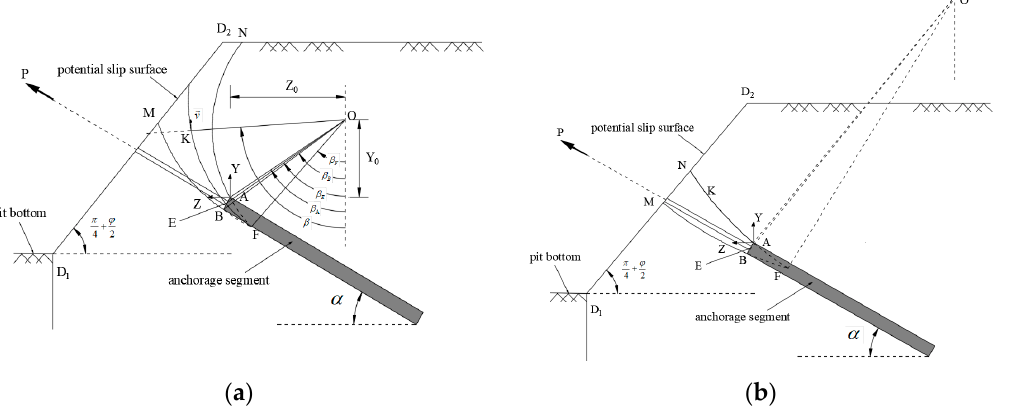
Figure 9. Cross-sections of the failure mechanisms for different coordinates of point O: ( a ) intersection with the ground surface, ( b ) all intersection with the potential slip surface.